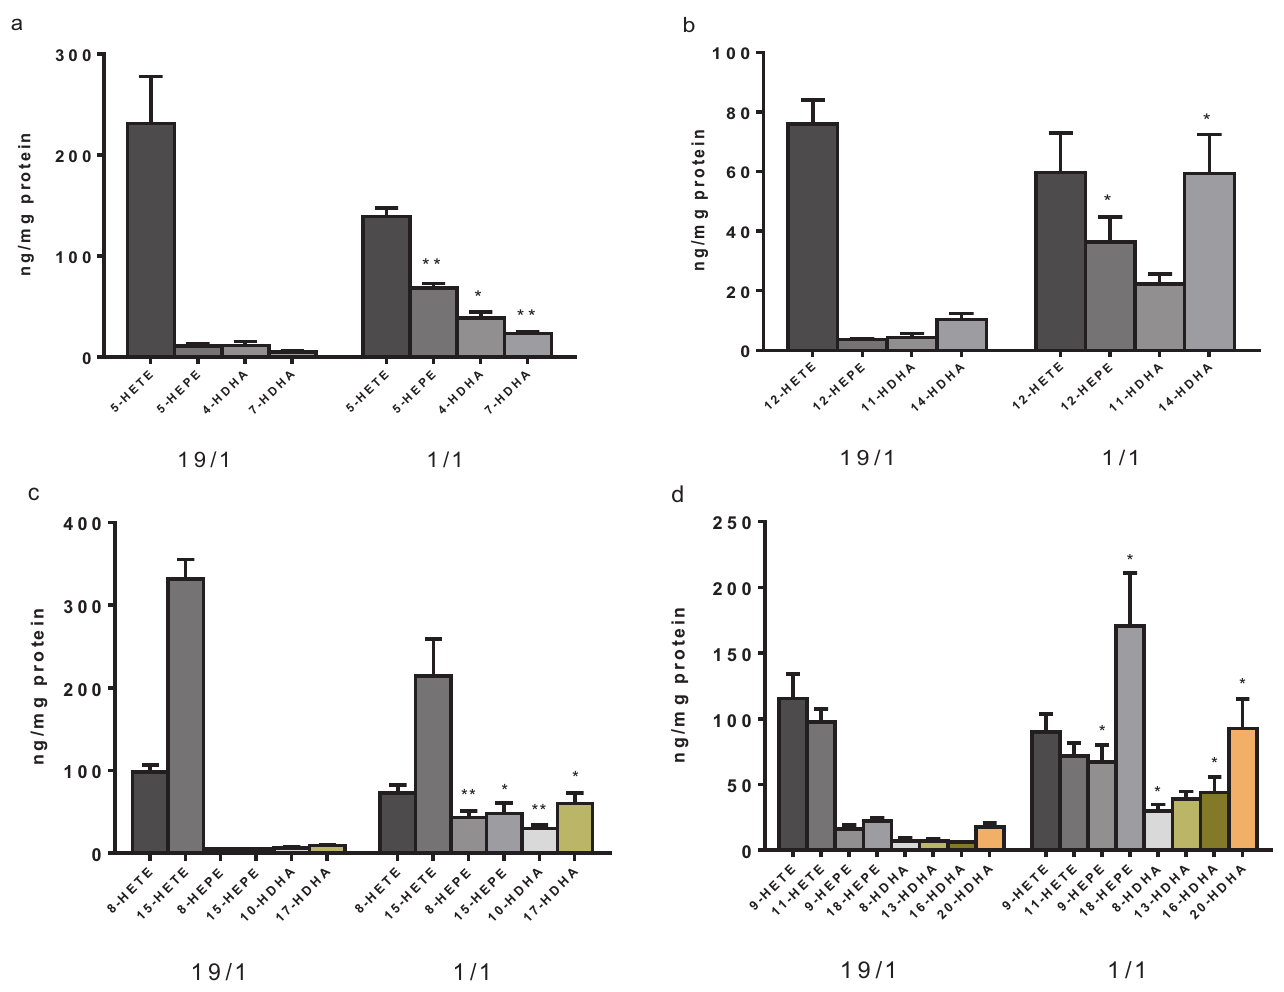
Figure 2. Metabolites that can be contributed to different LOX enzymes in a high ratio of AA/(EPA+DHA) (19/1) vs. low ratio of AA/(EPA+DHA) (1/1). ( a ) metabolites that can be formed by 5-LOX; ( b ) metabolites that can be formed by 12-LOX; and ( c ) metabolites that can be formed by 15-LOX, ( d ) metabolites not attributable to specific enzymatic or other metabolic pathways. * p < 0.05, ** p < 0.01 1/1 vs. 19/1